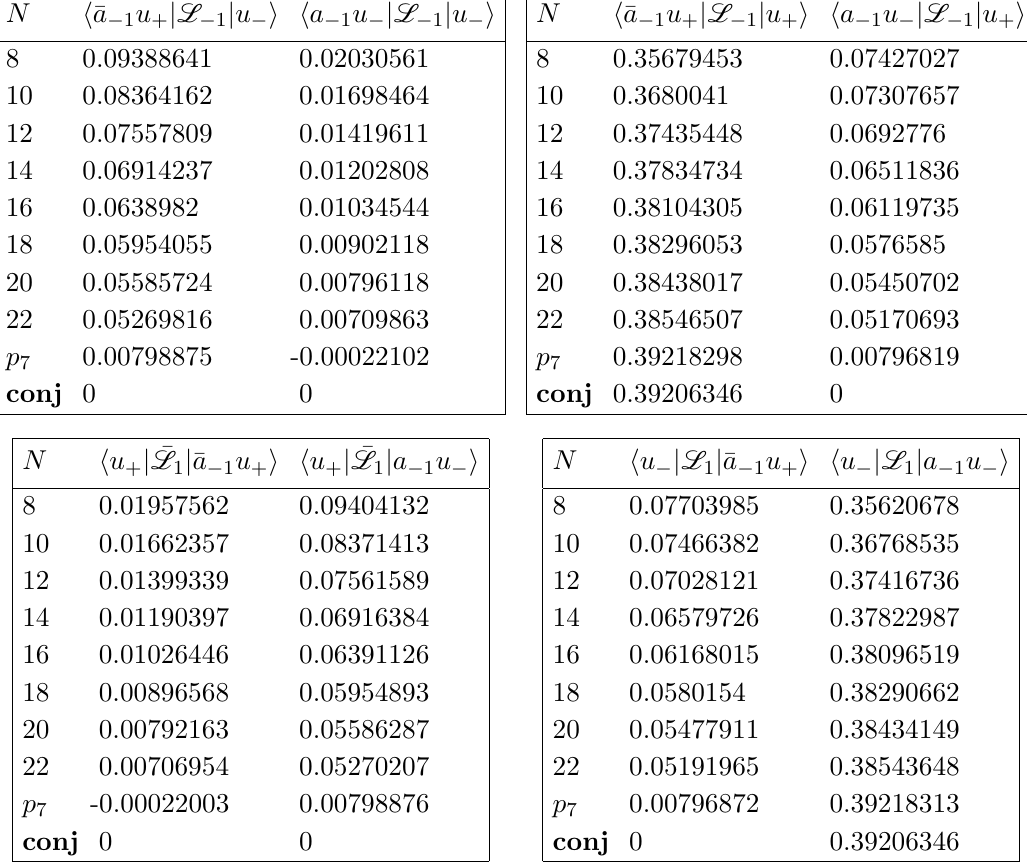
Table 4 . Matrix elements of L (cid:6) 1 and (cid:22) L (cid:6) 1 in the sector of S z = 1, at x = (cid:25) , with the same conventions as in table 3. Having separated j (cid:22) a (cid:0) 1 u + i and j a (cid:0) 1 u (cid:0) i from each other we here obtain the full conjectured norm. We note that strong duality does not apply to this table, since we no longer deal with single Bethe states but rather linear combinations